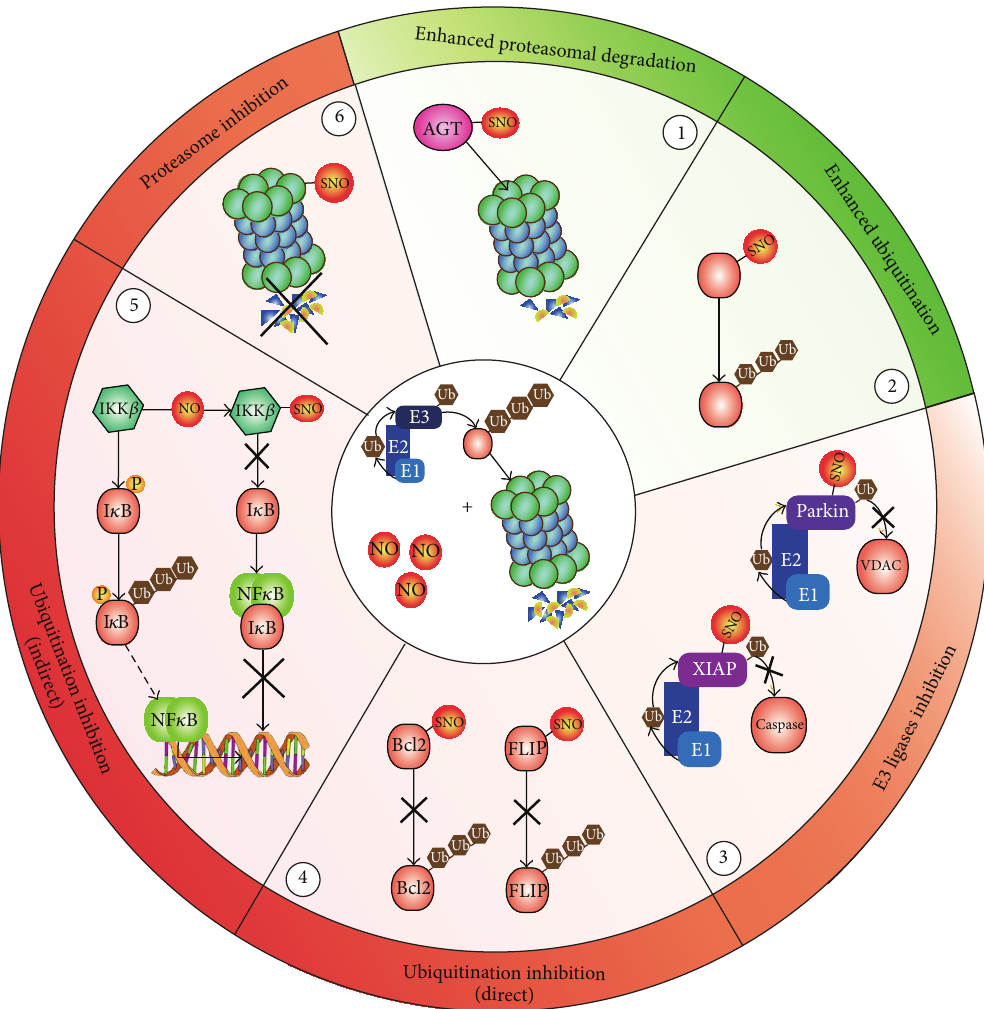
Figure 2: S -nitrosation-induced cellular effects on ubiquitin-proteasome system. Nitric oxide (NO) can target each one of the three components indispensable for protein ubiquitination and subsequent degradation: the ubiquitinating machinery (E1, E2, and E3 enzymes), the protein substrate, and the proteasome (center of the circle). S -nitrosation can enhance the degradation rate of the protein substrate (point 1, e.g., 𝑂 6 -alkylguanyl-DNA alkyltransferase, AGT) or its ubiquitination (point 2). Conversely, S -nitrosation can (i) inhibit ubiquitin ligase activity of several E3s, such as Parkin and XIAP (point 3), (ii) affect ubiquitination directly, by changing protein structure, as demonstrated for Bcl2 and FLIP (point 4), or indirectly, by inhibiting enzyme activities of proteins acting as positive modifiers of ubiquitination (e.g., IKK 𝛽 , point 5), and (iii) directly impair protasome activity (point 6). Red ring: inhibitory effects; green ring : activating effects.